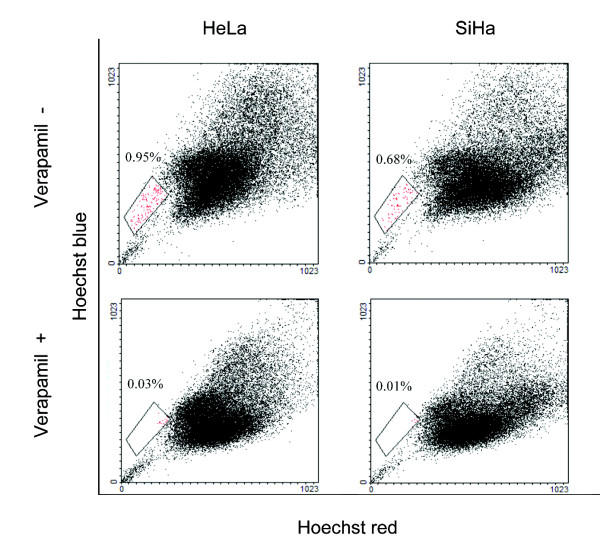
A side population (SP) is present in HeLa and SiHa cell lines. Flow cytometry trace from cervical cell preparation incubated for 90 min at 37°C with Hoechst dye as previously described by Goodell et al. (1996). Delimited red region is the (SP) fraction with and without Verapamil